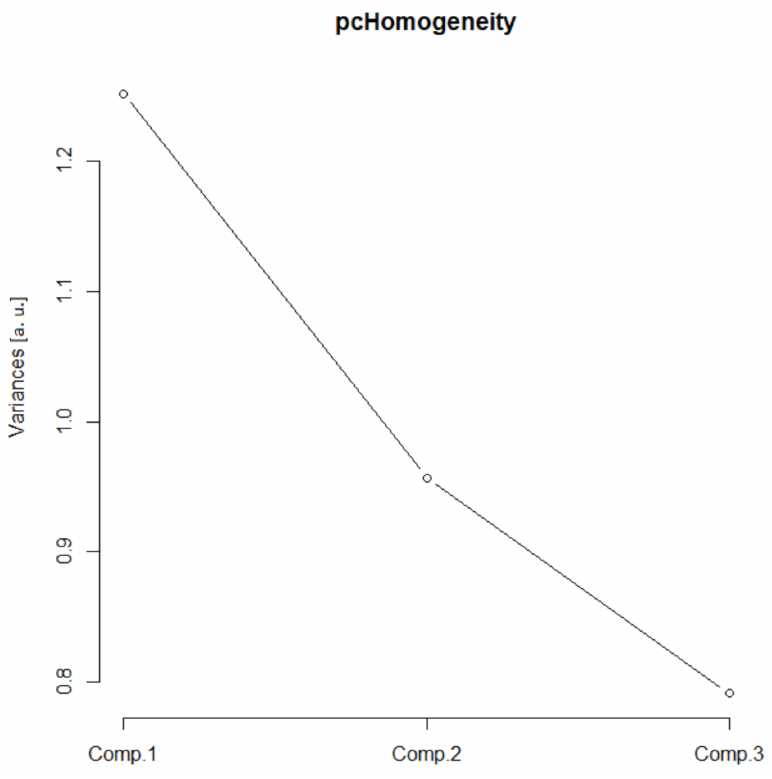
Figure 8. Homogeneity scree plot. The relationship between the variances (eigenvalues) and principal components for the homogeneity for the analyzed sample of astrocytes in the given group.